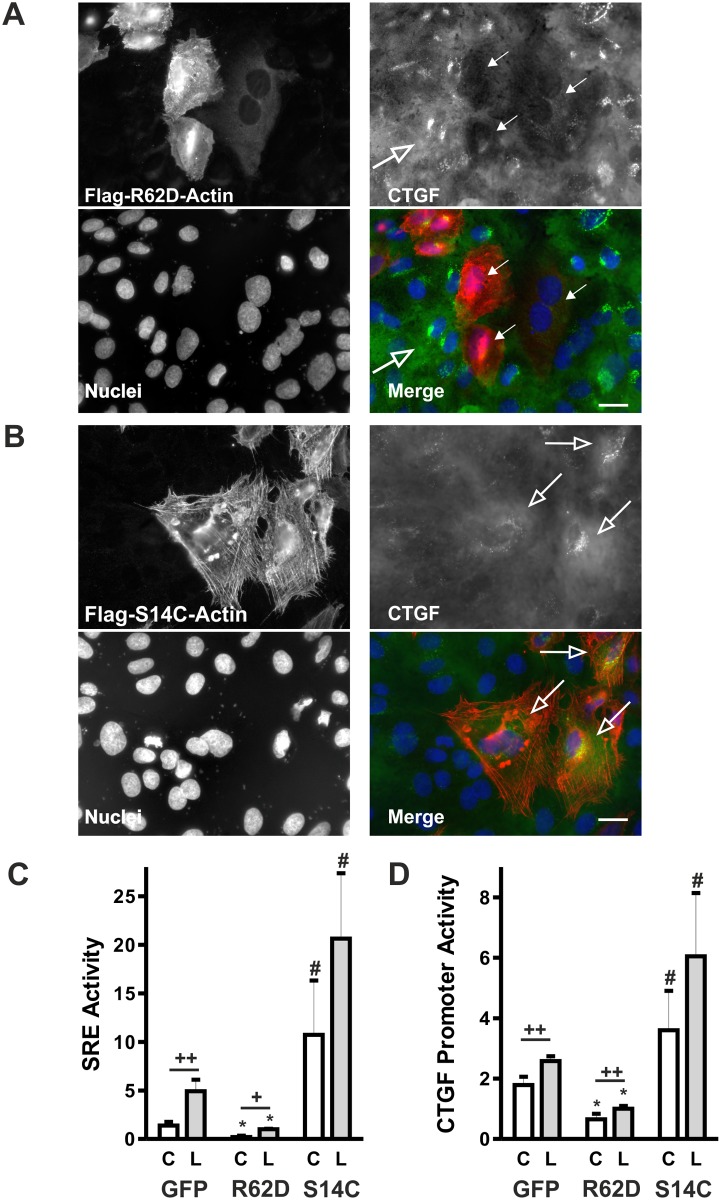
Actin mutants alter CTGF expression.(A) HKC-8 cells were transfected with the flag-tagged polymerization-defective actin mutant R62D. 24 h after transfection, cells were stimulated with LPA (10 μM) for 2 h. Mutated actin (anti-flag, red) and CTGF (green) were visualized by indirect immunofluorescence; nuclei were stained with Hoechst (blue). Open arrow indicates CTGF expression in a LPA-stimulated cell; closed arrows indicate low CTGF expression in actin R62D transfected cells. Scale bar: 20 μm. (B) HKC-8 cells were transfected with the flag-tagged polymerization favoring actin mutant S14C. Cells were fixed after transfection without further stimulation. Mutated actin (anti-flag, red) and CTGF (green) were visualized by indirect immunofluorescence; nuclei were stained with Hoechst (blue). Open arrows indicate CTGF expression in transfected cells. Scale bar: 20 μm. (C): HKC-8 cells were transfected with actin expression plasmids (actin R62D and S14C) or eGFP as control and with a luciferase-coupled promoter construct comprising three SRE elements. Expression of cotransfected beta galactosidase was used as reference. Cells were stimulated with LPA (L, 10 μM) for 4 h and compared to control cells (C). Data are means ± SD of 2–4 experiments with biological duplicates. SRE activity of LPA-stimulated actin R62D-transfected cells was set to 1. # p < 0.01 compared to the respective R62D actin- or eGFP-transfected cells; * p < 0.001 analyzed separately compared to eGFP-treated cells. ANOVA with Tukey’s multiple comparison test; ++ p<0.001, + p<0.05, analysis of eGFP and R62D treated cells, LPA-stimulated cells compared to control cells. (D) Cells were treated as in (C), but co-transfected with a 4.5 kb CTGF promoter construct. # p < 0.01 compared to the respective R62D actin- or eGFP-transfected cells; * p < 0.01 analyzed separately compared to eGFP-treated cells. ANOVA with Tukey’s multiple comparison test; ++ p<0.001, analysis of eGFP and R62D treated cells, LPA-stimulated cells compared to control cells.